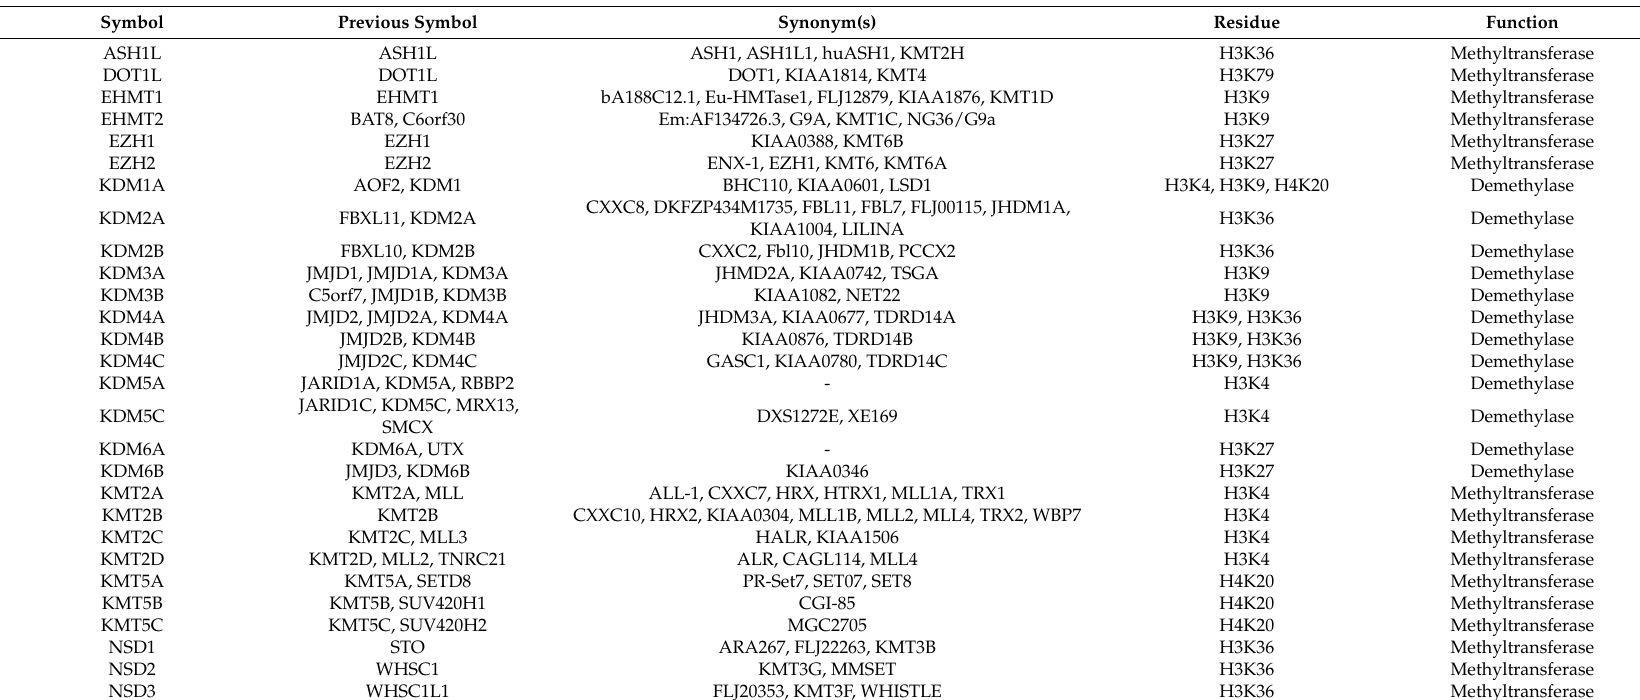
Table 1. The names of the histone methylation-related factors mentioned in this paper and their